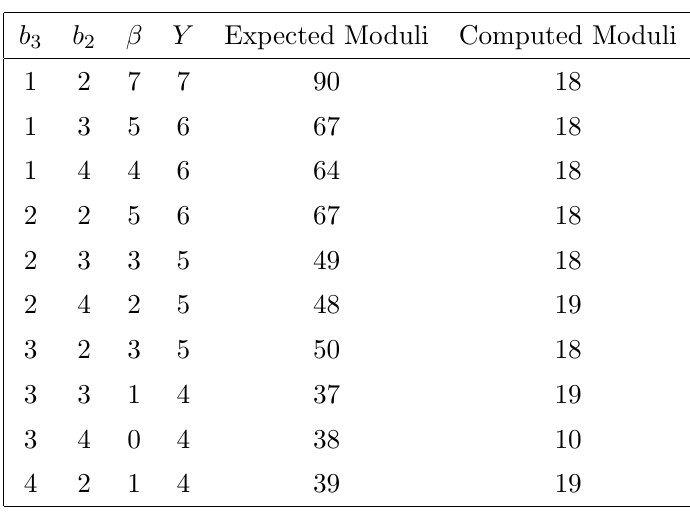
Table 9 . Expected number of moduli from 6D anomaly cancellation for the gauge algebra su (3) (cid:8) su (2) (cid:8) u (1) along with the number of moduli counted for the Weierstrass model (3.1) using the Jacobian rank method (subtracting 8 to account for the automorphisms of the base P 2 ), for all P 2 models where the Jacobian rank method provides an undercount. These are precisely the cases where the discriminant vanishes identically. Both (cid:12) and Y are given for convenience, though either is su(cid:14)cient to determine the other, given b 3 ; b 2